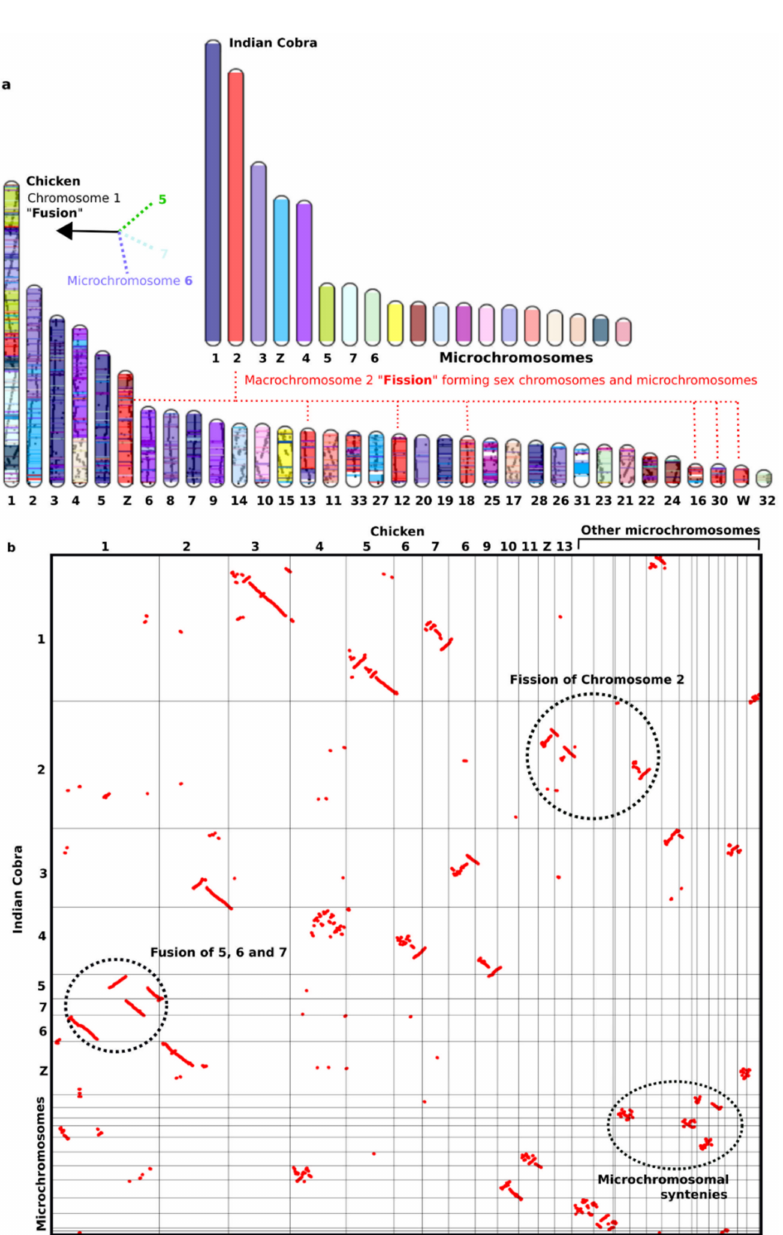
Figure 2. Cross-species homology relationship of microchromosome syntenies and inter/intra- chromosomal rearrangements for the analyzed species. ( a ) In silico chromosome map of Indian cobra and chicken chromosomes. Same colors correspond to syntenic regions between different chromosomes. ( b ) A dot-plot view of genomic comparisons indicate different evolutionary patterns of chromosomal rearrangements, such as fusion, fission and microchromosomal